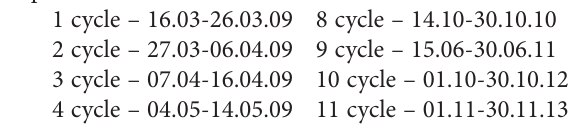
Figure 1. Schematic map of ecological state of geological environment (source: Gherasimov et al., 2004) Tectonically, the region is located on the border of the Eastern European (ancient) and Western European (young) platforms, the boundary between which runs along the Novovolynsk and Radekhiv-Rohatyn-Monastyrsky faults,